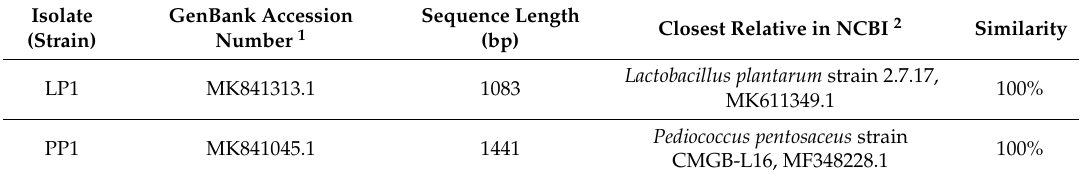
Table 1. Identification of the LAB strains, used in the present study, by 16S rRNA gene